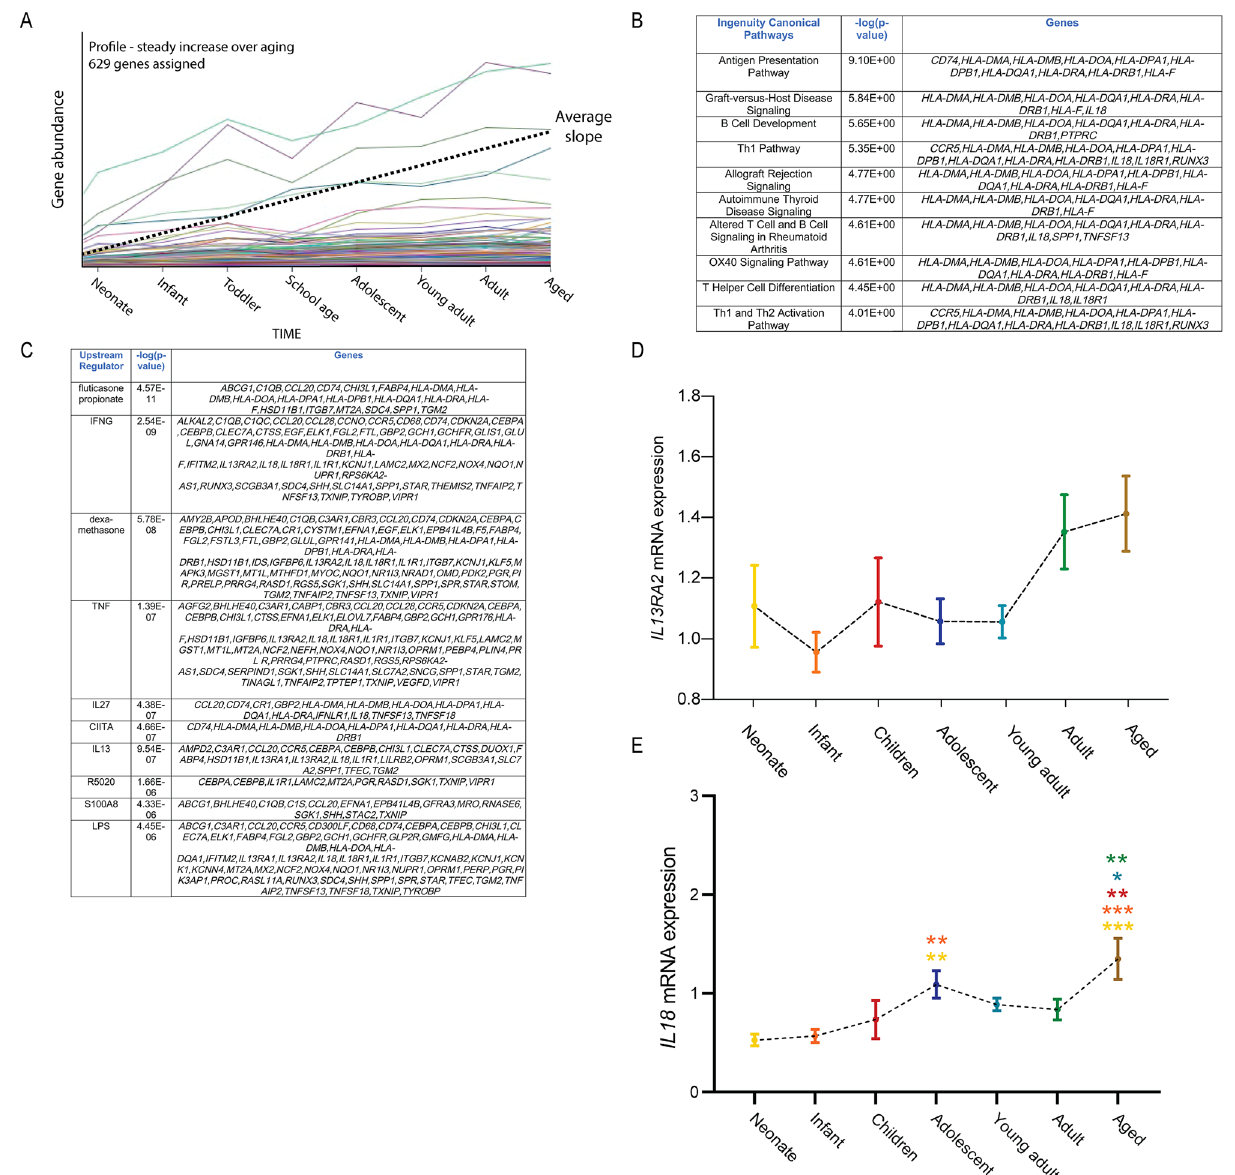
Figure 4. Transcripts whose expression rose steadily over the course of aging. ( A ) The second major profile that we identified related to genes whose expression increased steadily over the course of aging. There were 629 genes associated with this profile. Ingenuity analysis revealed many immune-associated pathways associated with this profile ( B ), as well as many immune-associated upstream regulators potentially linked to it ( C ). ( D , E ) qPCR analysis confirmed the steady rise in the expression of IL13RA2 ( D ) and IL18 ( E ). Colours for significance (***) correspond to the colour of the age group used in the comparison. * p < 0.05, ** p < 0.01, *** p < 0.001; Analysis of variance, post hoc tests using